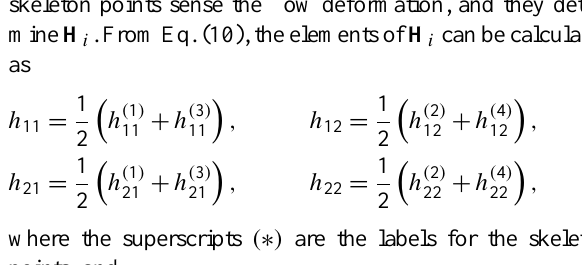
Figure 2. Four skeleton points (black points) associated with a par- cel. Their spatial coordinates will change with the flow, but the body coordinates in remapping space are fixed. The red point is the major axis vertex of the